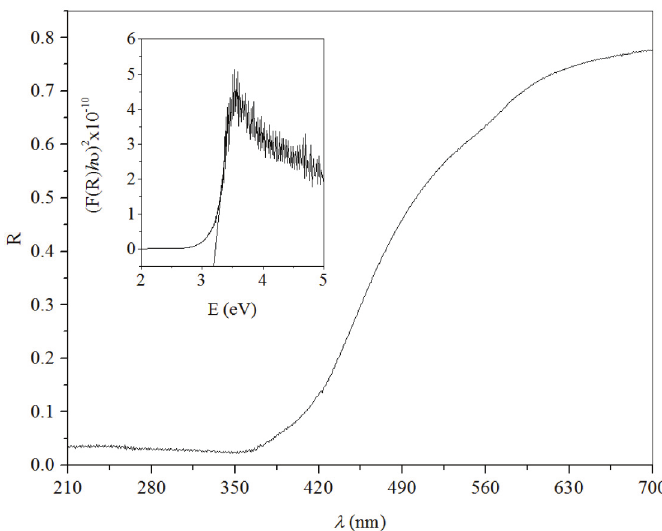
Fig. 5 – UV–Vis diffuse reflectance spectrum of the prepared catalyst. Inset: Modified Kubelka-Munk function for the direct transition.